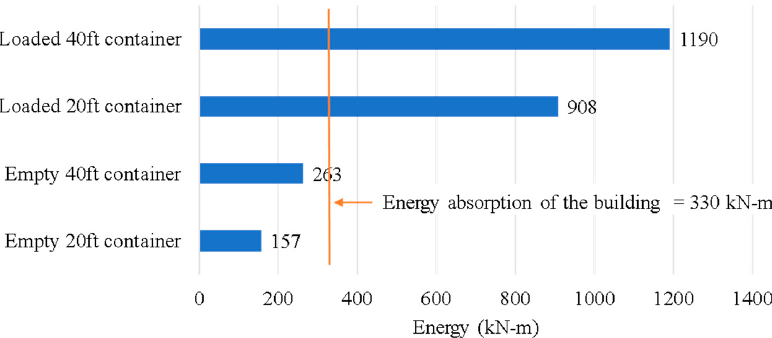
Figure 12. Comparison of energy absorption of the building for cases Ia and Ib.